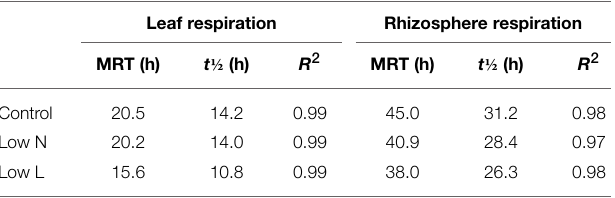
TABLE 2 | Carbon mean residence time (MRT), half-life time (t ½ ) and coefficient of determination (R 2 ) in respiratory substrate pool (calculated from exponential decay functions of δ 13 CO 2 ).